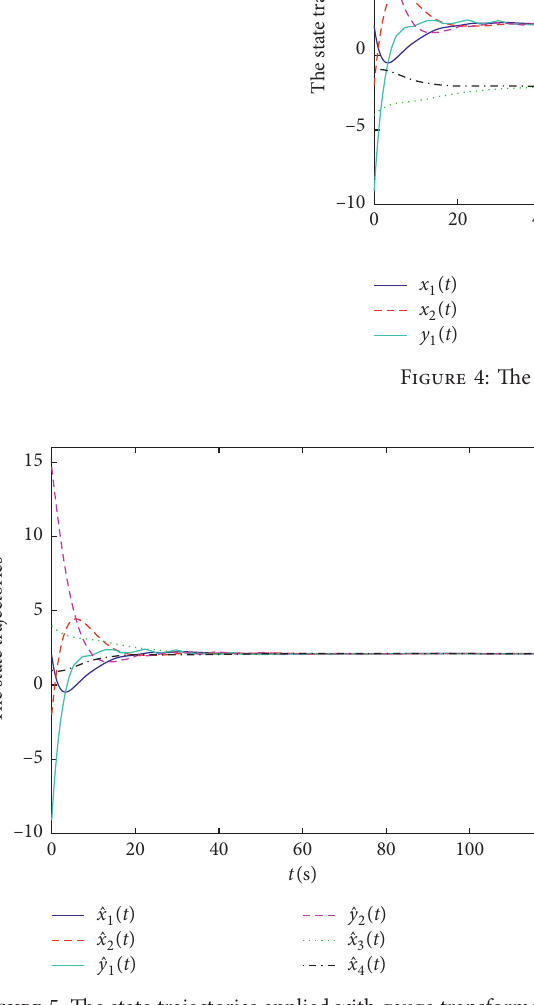
Figure 5: The state trajectories applied with gauge transformation when τ �